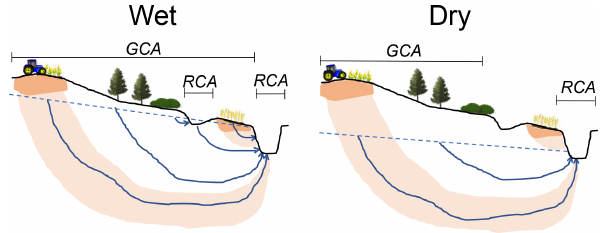
Figure 10. Contributing areas fluctuate with wetness conditions due to changing flow paths. GCA is the groundwater contributing area, which is where discharge was infiltrated, and RCA is the runoff contributing area, which is where discharge is generated. Areas be- tween the two different contributing areas are inactive and do not actively influence stream